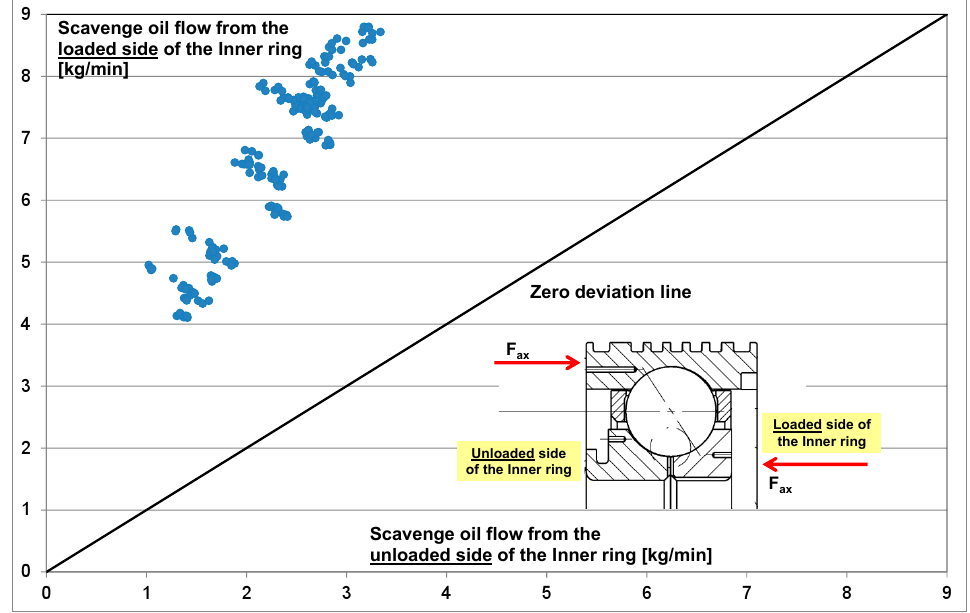
Figure 6. Lubrication oil discharge (scavenge oil) from both sides of the bearing.